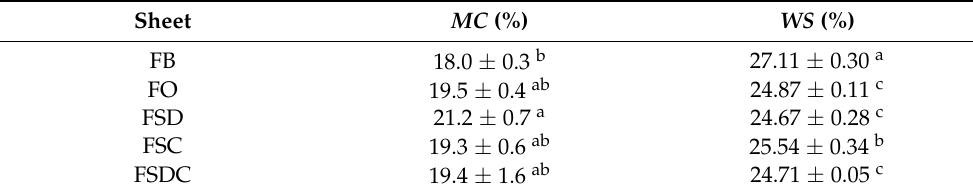
Table 3. Characterization of control sheet (FB) and sheets incorporated with tucum ã oil (FO) and its microparticles (FSD, FSC and FSDC), obtained by different encapsulation methods, regarding their moisture content ( MC ) and water solubility ( WS